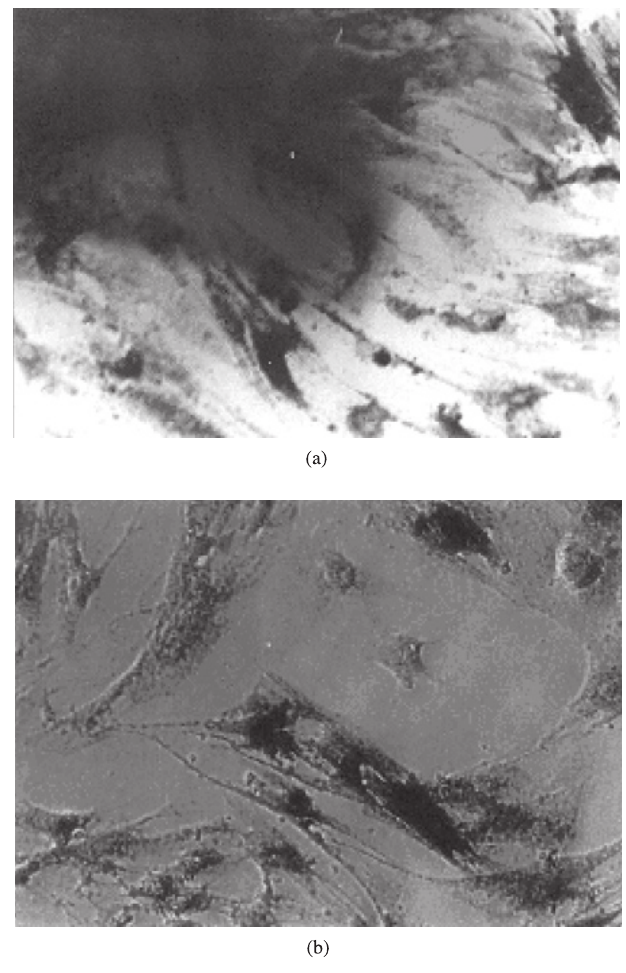
Figure 7. Osteoblastic cell activity indicated by the production of alkaline phosphatase: purple precipitates indicate the presence of alkaline phosphatase in cultures a) in which cells were cultured in contact with the nanocomposite (darker region: biomaterial) and b) on TCPS with no